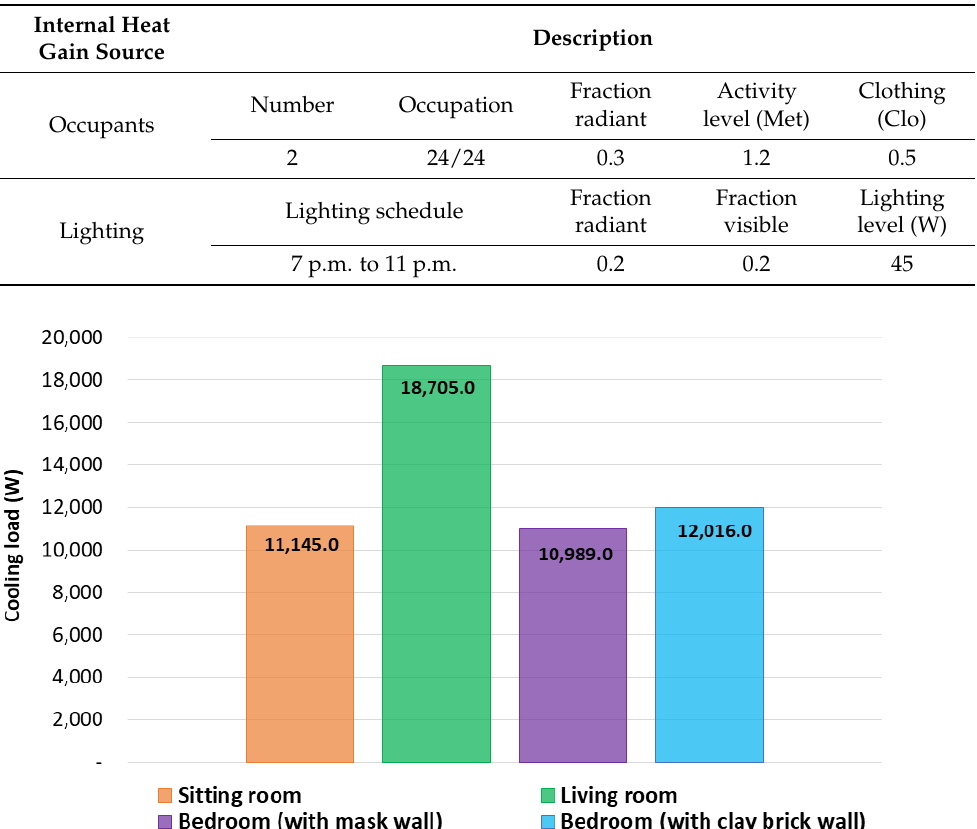
Table 9. Details of the internal heat gain sources.